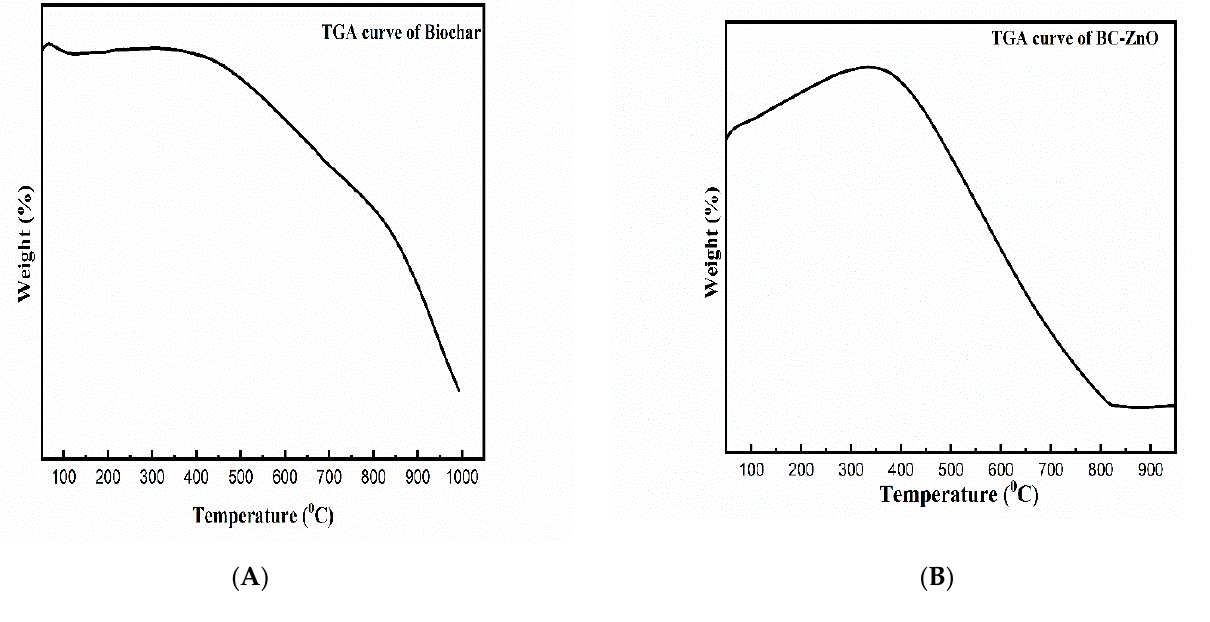
Figure 5. TGA of pure biochar ( A ) and MB-ZnO ( B